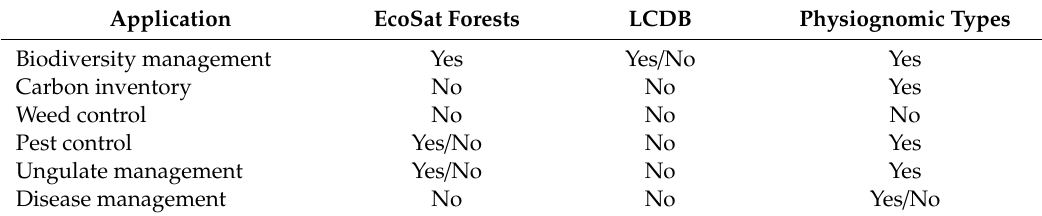
Figure 3. Plot of Sentinel-1 ratio of VH/VV versus 97th percentile of canopy height for Beech forest (crosses) and Broadleaved-podocarp forest (circles). Table 6. Fitness for purpose of method presented in this paper (labelled “Forest Physiognomic Types”) for major management applications for indigenous forest in New Zealand, compared with EcoSat Forests and Land Cover Database (LCDB).